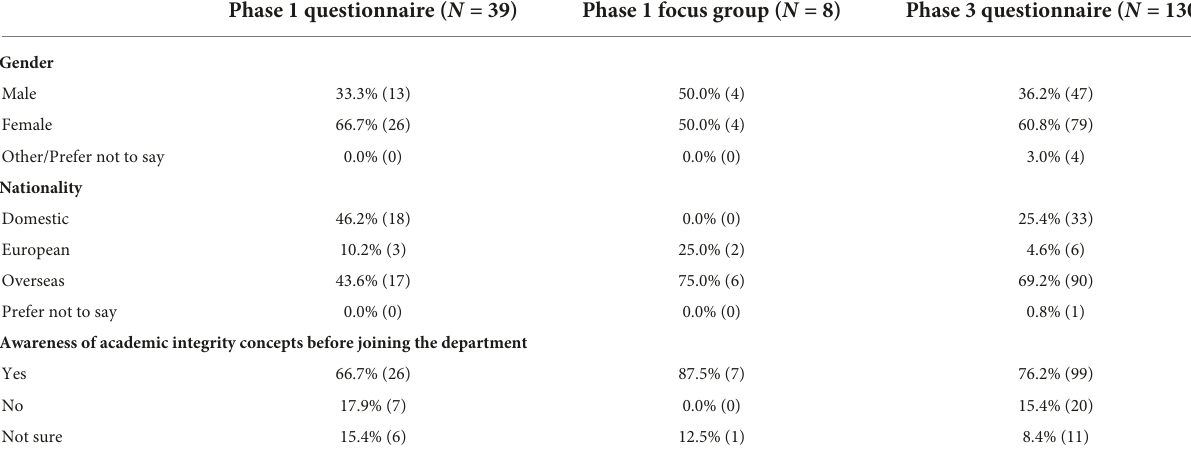
TABLE 1 Demographic characteristics of the students participating in the